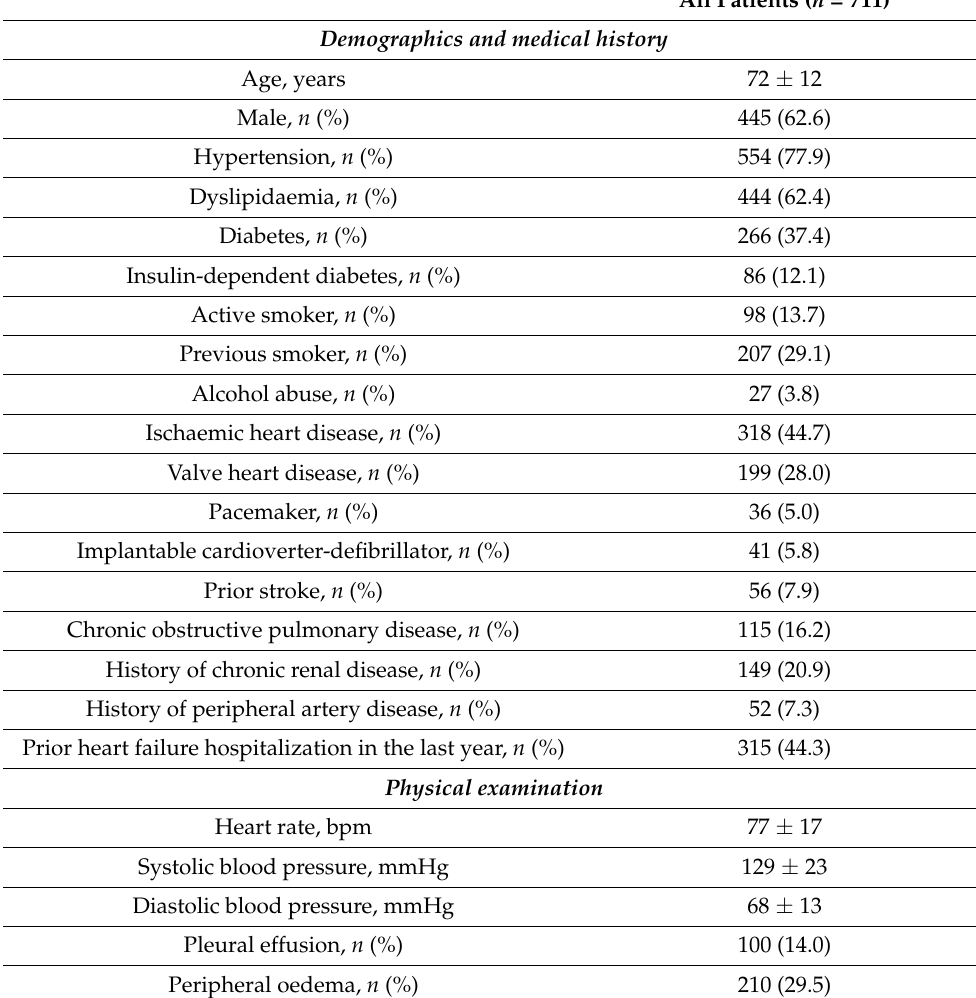
Table 1. Baseline